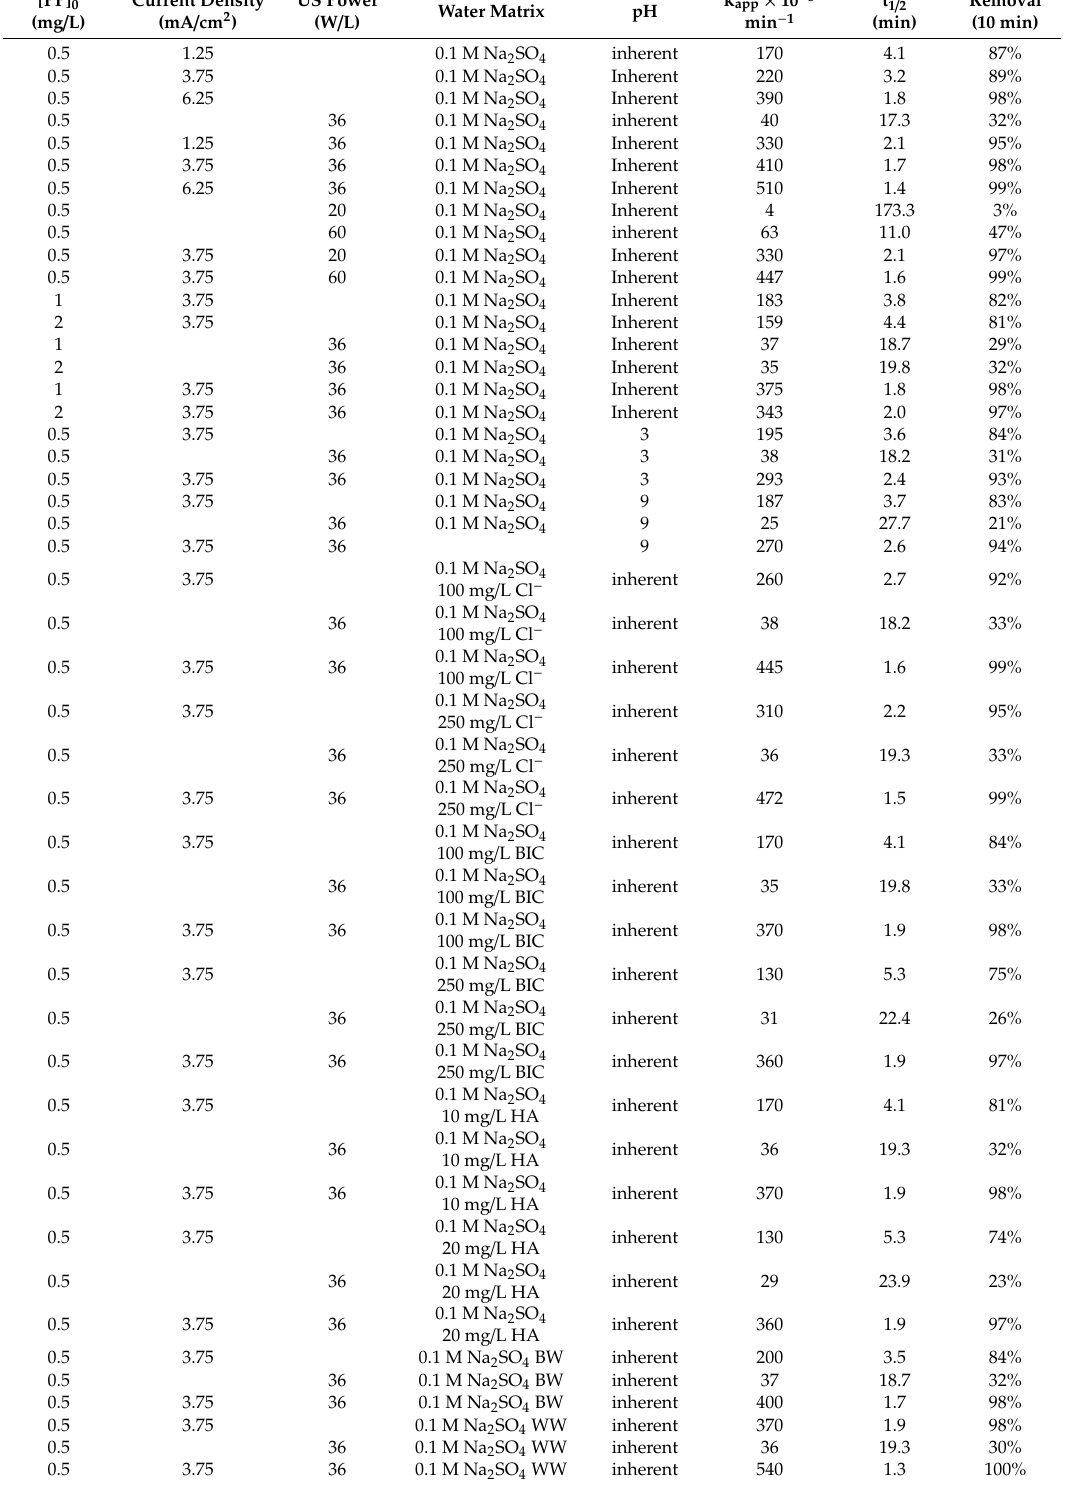
Table 2. Summarized data from Figures 1–7. HA: Humic Acid. BIC: Bicarbonates, BW: Bottled Water, WW: